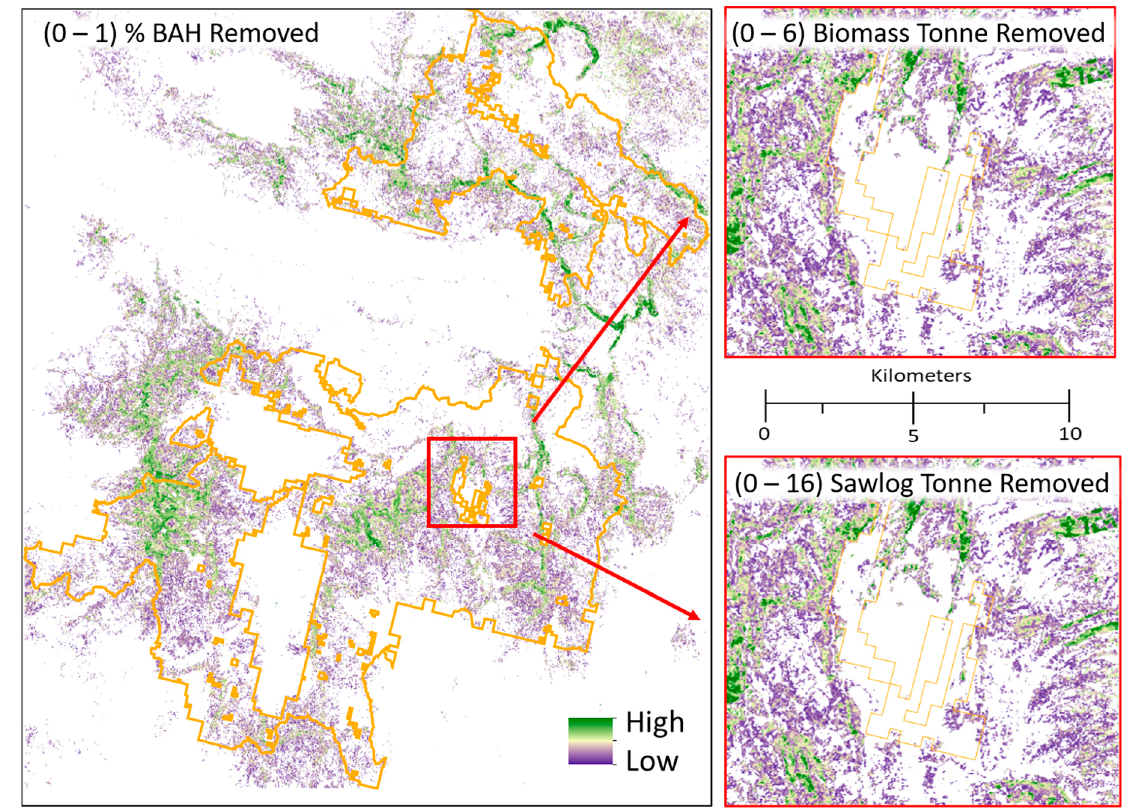
Figure 8. Zoomed-in illustration of biomass and sawlog tonne removed (red box). Tonne removed was derived from % basal area ha − 1 reductions required to meet desired future condition thresholds. The range of cell values within each graphic are displayed within graphic title parentheses. Orange collaborative forest landscape restoration program polygons are displayed for reference in the various graphics.